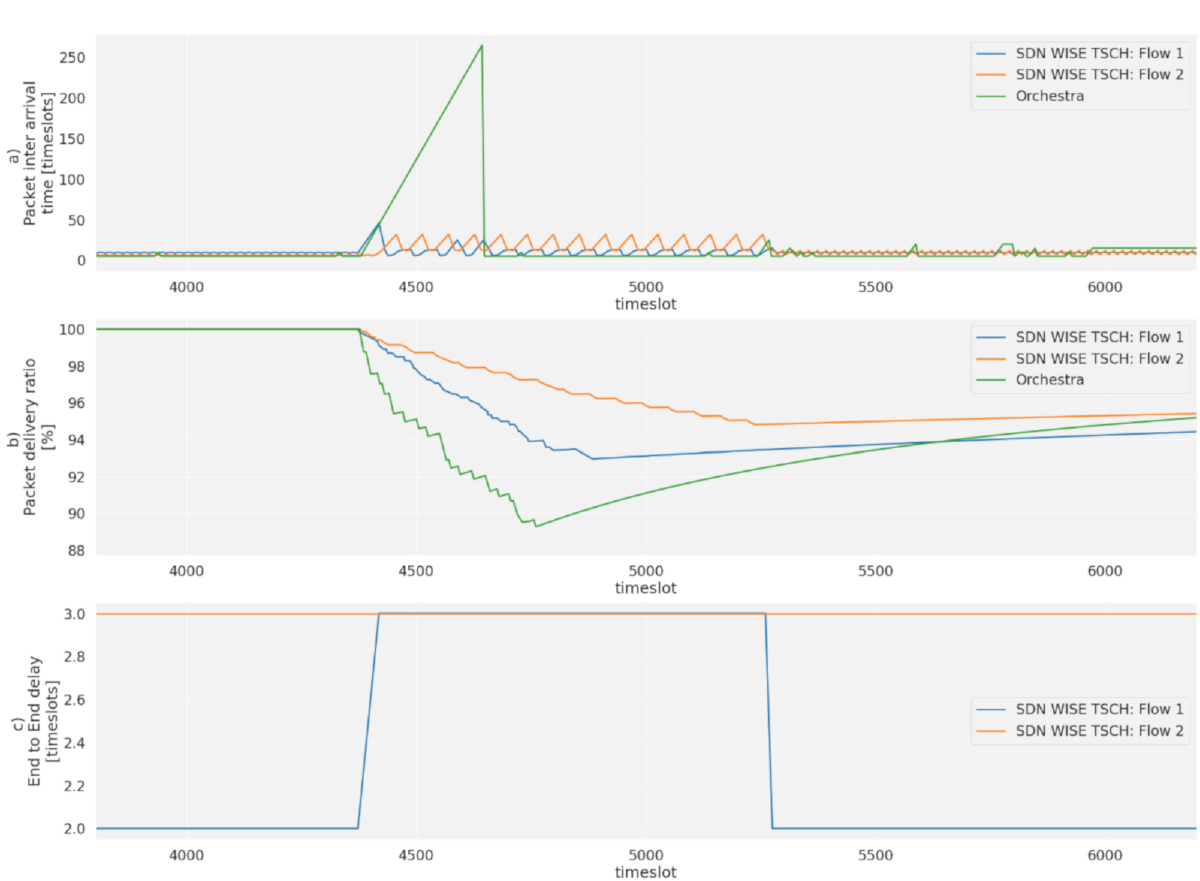
Figure 14. Comparison between SDN WISE TSCH and Distributed Scheduling.